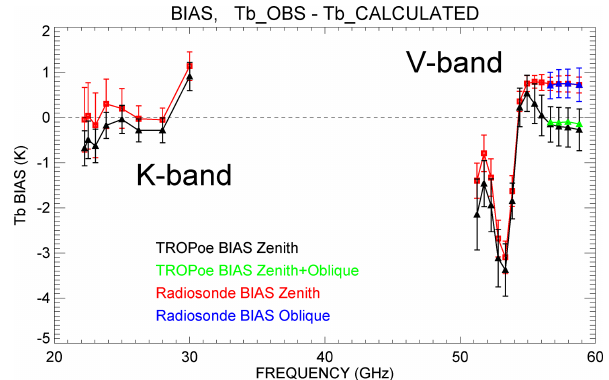
Figure 1. T b biases derived from the radiosonde BC method (and TROPoe BC method) in all 22 MWR channels of the zenith scan in red (and in black) and in the four opaque channels of the oblique scans in blue (and in